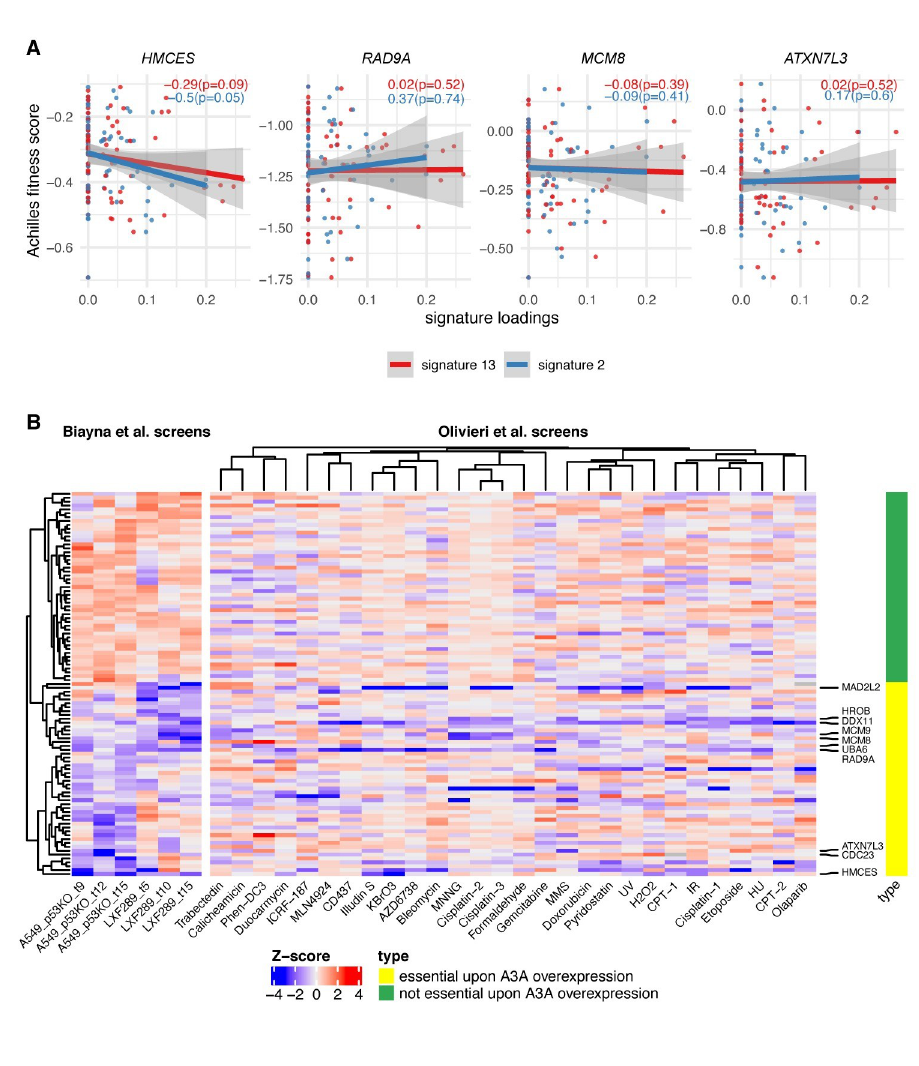
Fig 3. Dependency on HMCES is associated with mutational signatures of APOBEC across 76 lung and head and neck cancer cell lines. ( A ) Gene essentiality fitness score from Project Achilles vs. APOBEC mutational signatures exposures, for cell lines from head and neck squamous cell carcinoma, LUAD, and lung squamous cell carcinoma, in four of the genes with the greatest overall score in our screens; see S5 Table and S7 Fig for associations with additional prominent genes. The slope and p -value (1-tailed, lower) for the regression model for both A3 signatures are shown within each panel. The more negative the slope, the more sensitive the cell lines are to the depletion of the gene at a higher level of the APOBEC signature. ( B ) Heatmap shows a gene-level normalized LFC (gene essentiality score) upon A3A overexpression for 2 cell lines and for 3 time points (Biayna et al. screens); right panel shows Z-scores of gene essentiality after genotoxin exposure (Olivieri et al. screens[60]). Data for 50 genes that are essential upon A3A overexpression in our screens (i.e., genes with the most negative mean LFC across 6 data points) and 50 nonessential genes upon A3A overexpression in our screens. Labels on the right-hand side highlight the 10 genes showing the highest overall A3A essentiality. An extended heatmap showing all genes from certain DNA repair pathways is included in S7 Fig, and numerical data for graphs in this figure are provided in S3 Data. A3A, APOBEC3A; LFC, log 2 fold change; LUAD, lung